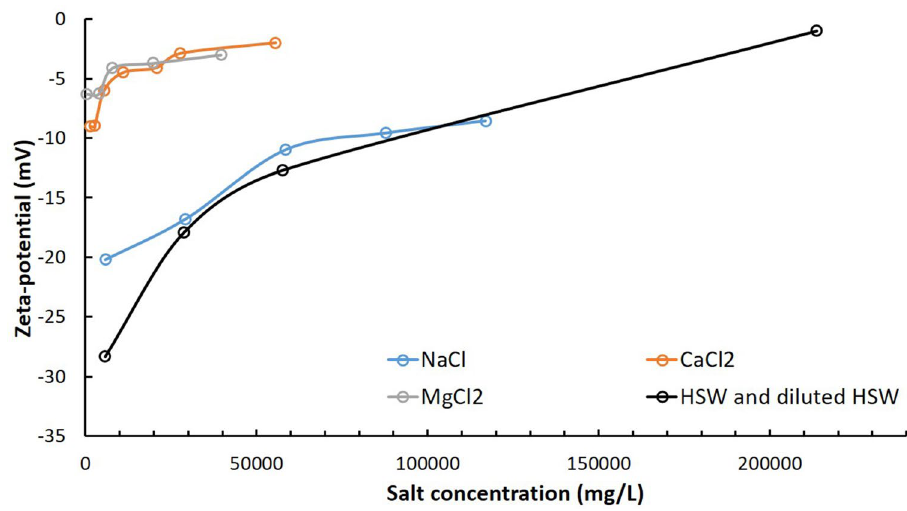
Figure 1. Zeta-potential of oil droplets in different salt